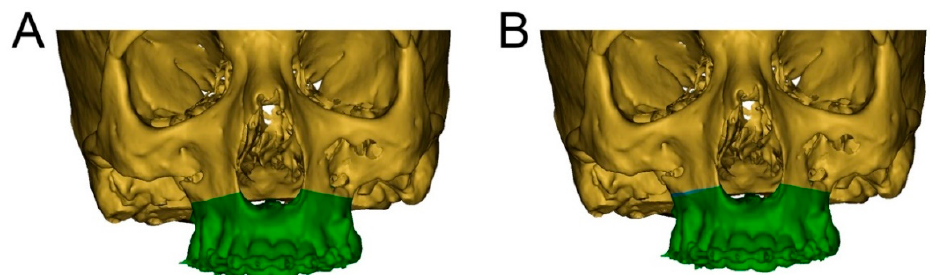
Figure 2. Segmentation of the cranium (green) and maxilla (brown) with preoperatively planned and intraoperatively adjusted osteotomy lines. ( A ): Preoperatively planned left and right linear midface osteotomy lines in Mimics. This model is exported as an STL file and then imported into the software of the CARLO ® device. ( B ): Intraoperatively adjusted osteotomy line on the right side of the maxilla, marked in blue.